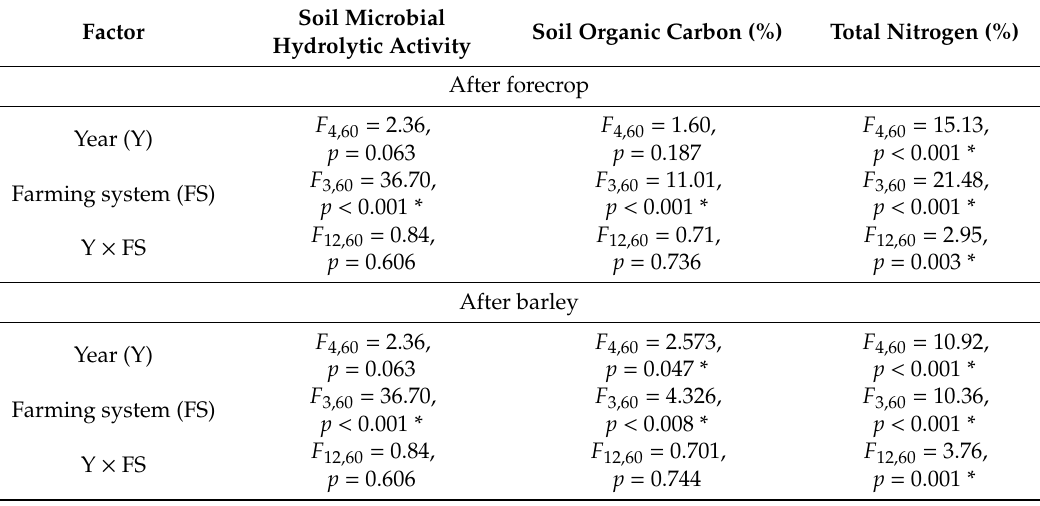
Table 1. Impact of trial factors on soil microbial hydrolytic activity ( µ g of fluorescein g − 1 soil dry weight h − 1 ), soil organic carbon (%) and total nitrogen (%)